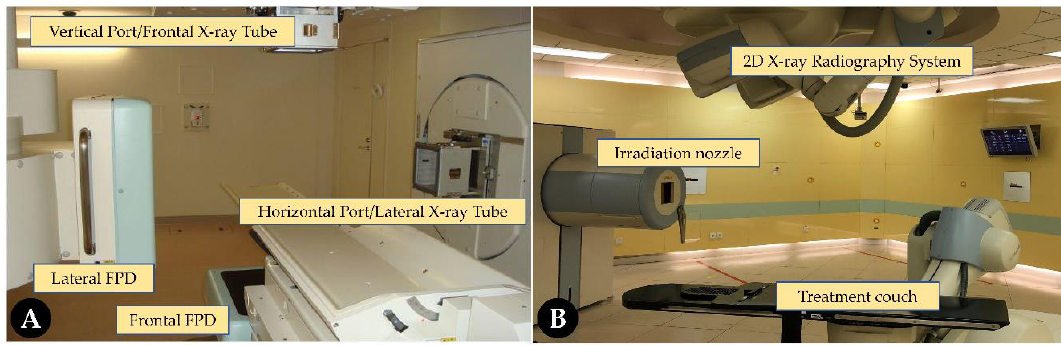
Figure 2. Carbon ion facilities with two-dimensional imaging systems by Shimadzu ( A ) and Siemens AG ( B ). FPD: flat panel detector; AG: Aktien